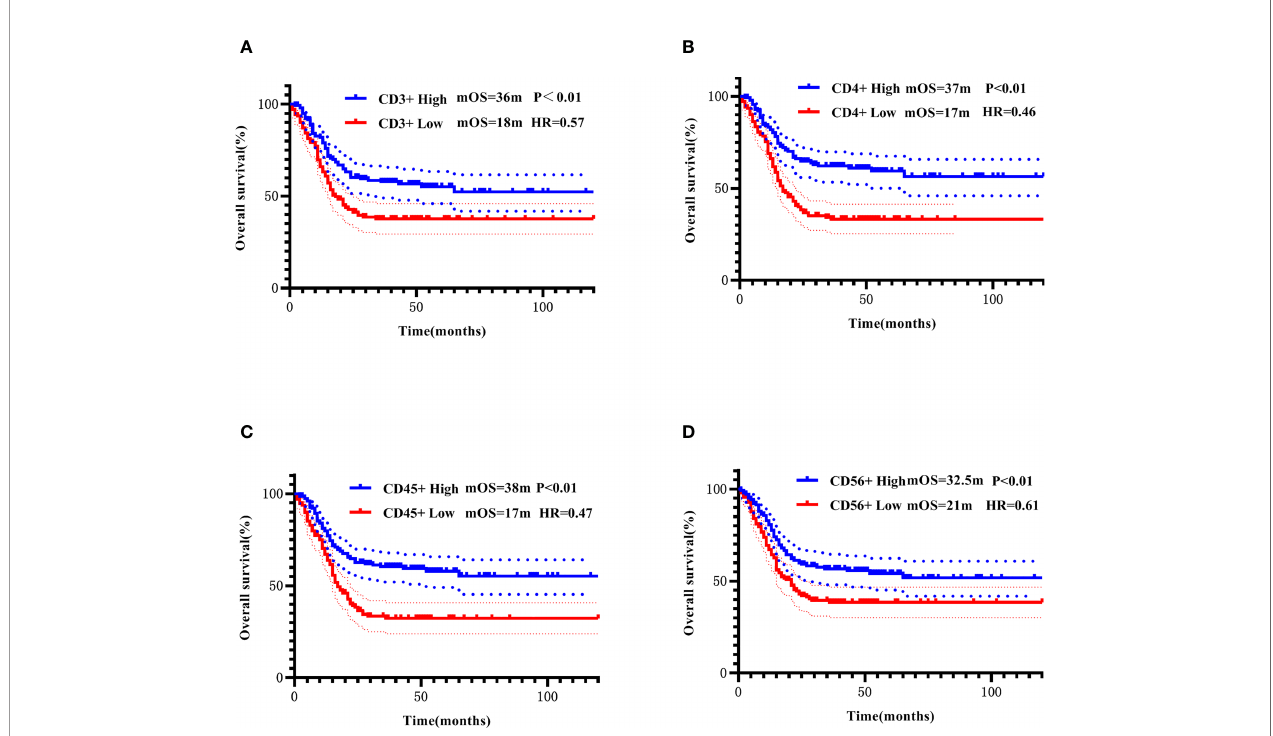
FIGURE 4 | Correlation of CD3+ (A) , CD4+ (B) , CD45+ (C) , and CD56+ (D) with OS addressed by the Kaplan-Meier method and log-rank test.